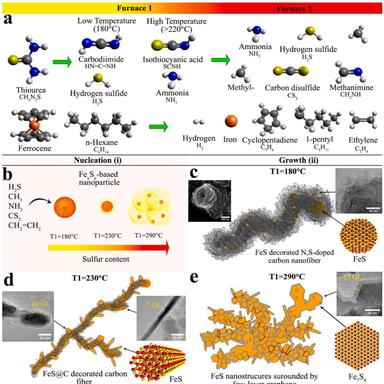
Cristina L. Rodríguez-Corvera et al. (a) Possible scenarios for the thermal decomposition of precursors to synthesize the hybrid carbon nanostructures. (b) Nucleation mechanism for the three different temperatures used in this work. As the temperature in furnace-1, it increases, the sulfur abundance reaching the furnace two rises, producing catalyst poisoning, and FexSy phases are formed. (c) Growth stage of robust carbon fiber from a FeS nanoparticle. (d) Smaller hybrid carbon fiber decorated with rods o